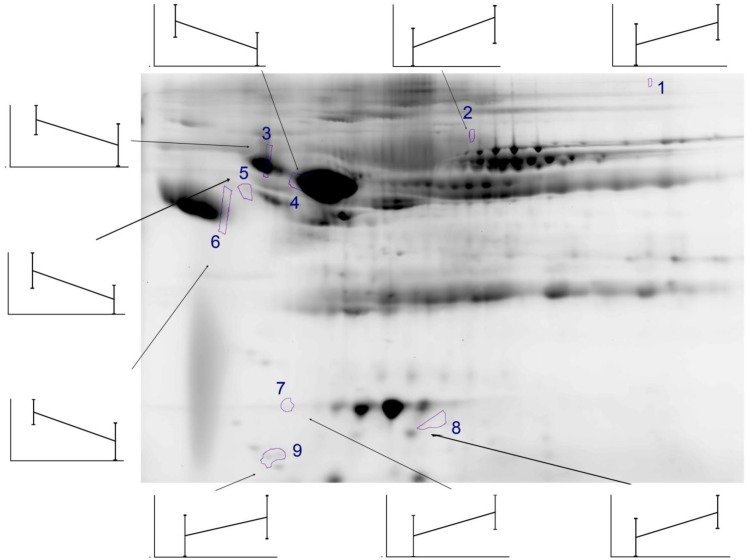
Reference gel of plasma proteins dysregulated by IPA.Shown is a reference gel of 2DE of SEC fractionated and IgY depleted plasma proteins from the study subjects. The location of 9 spots, identified as candidate discriminant proteins are shown. Spot #1 is FIBB; #2 is ALBU; #3 is AATL; #4 is A1AT; #5 is LRG1; #6 is A1AG1; #7 is APO A1; #8 is FIBA; and #9 is APO C3. The image shown represents the pI range of 3–10 and the molecular size range of 25–200+ kDa. Inset, average abundance of each protein spot is shown graphically for Case (Left) and Control (Right) as shown for protein spot # 1.